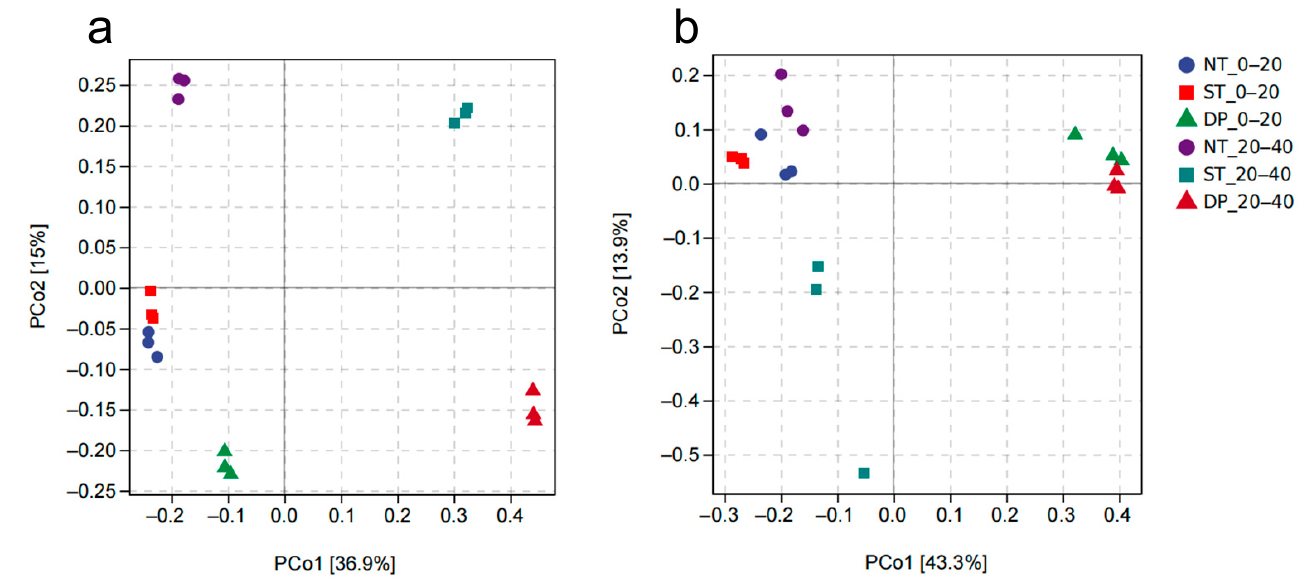
Figure 3. Principal coordinate analysis of bacterial ( a ) and fungal ( b ) community structure based on Bray–Curtis Distance in the 0–40 cm soil layer during the fallow period. NT: no-tillage; ST: subsoiling tillage; DP: deep plowing.